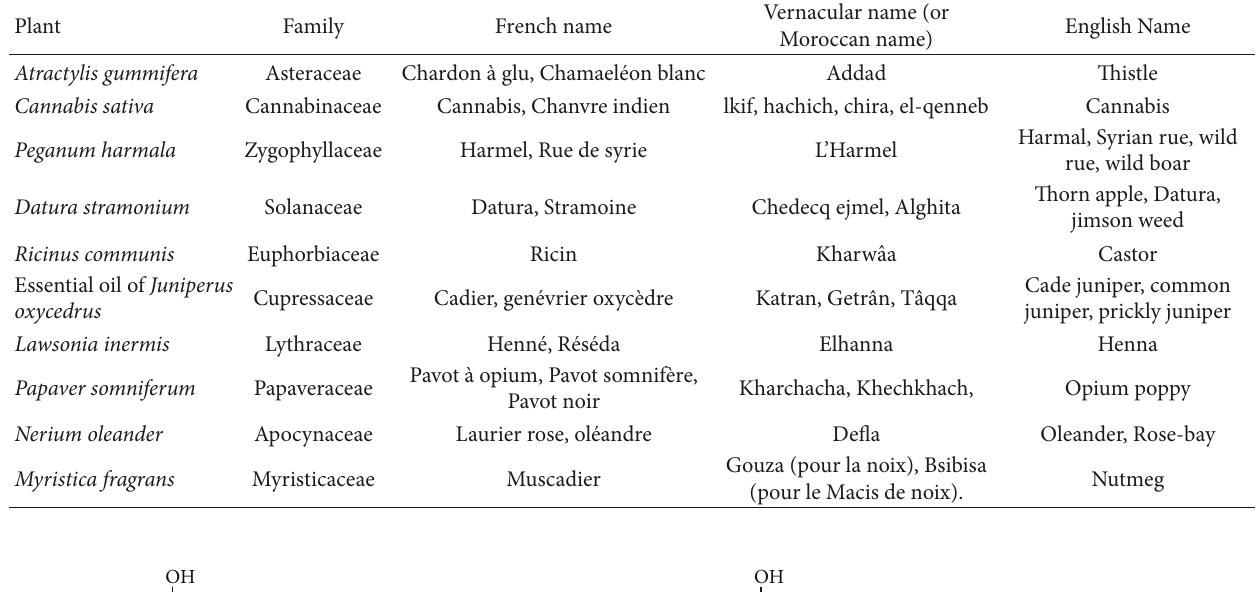
Table 2: Families and different nomenclature of the most toxic plants in Morocco.